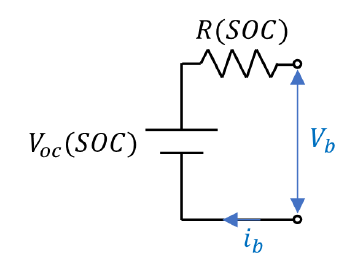
Figure 6. Scheme of the battery model using its Thevenin equivalent